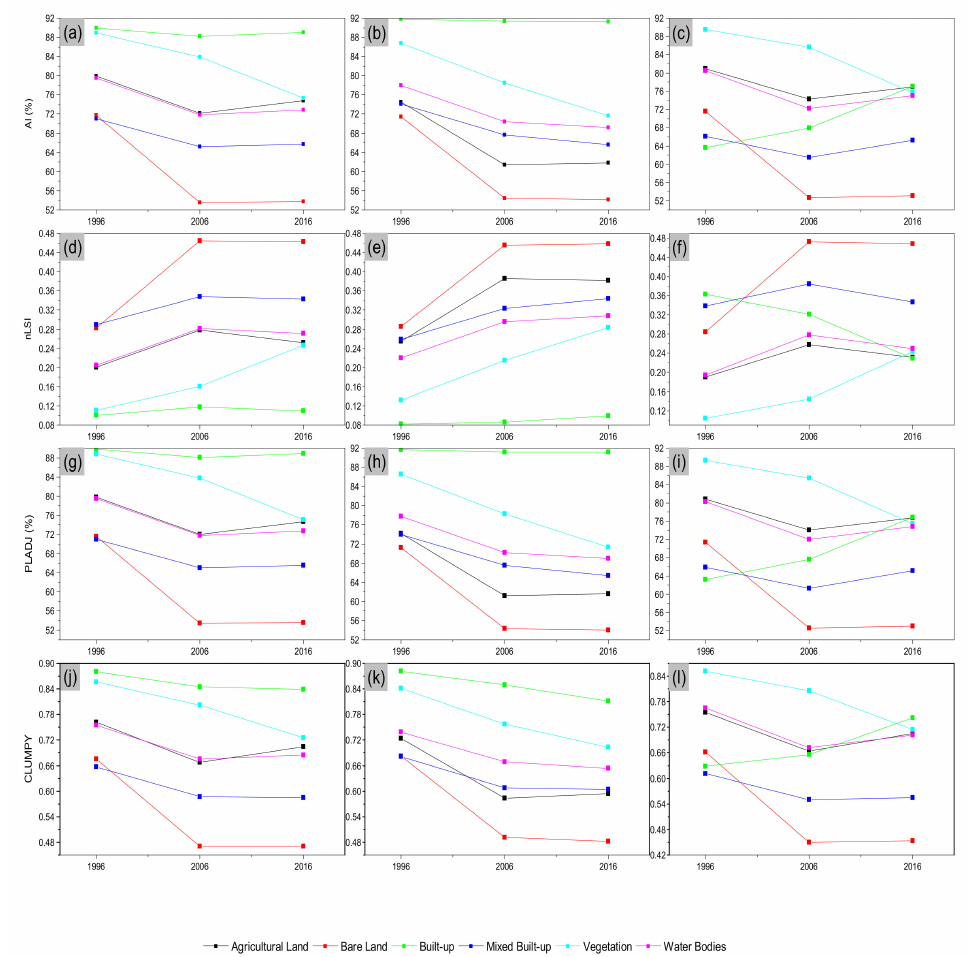
Figure 15. Class level aggregation metrics over KMA, KMA-urban, and KMA-rural with their temporal dynamics during 1996–2016; ( a – c ) represent AI for KMA, KMA-urban, and KMA-rural, respectively, in 1996, 2006, and 2016; ( d – f ) show the temporal trend of nLSI for KMA, KMA-urban, and KMA-rural, respectively, in 1996, 2006 and 2016; ( g – i ) depict temporal dynamics in PLADJ for KMA, KMA-urban, and KMA-rural, respectively, in 1996, 2006, and 2016; ( j – l ) present CLUMPY for KMA, KMA-urban, and KMA-rural, respectively, in 1996, 2006, and